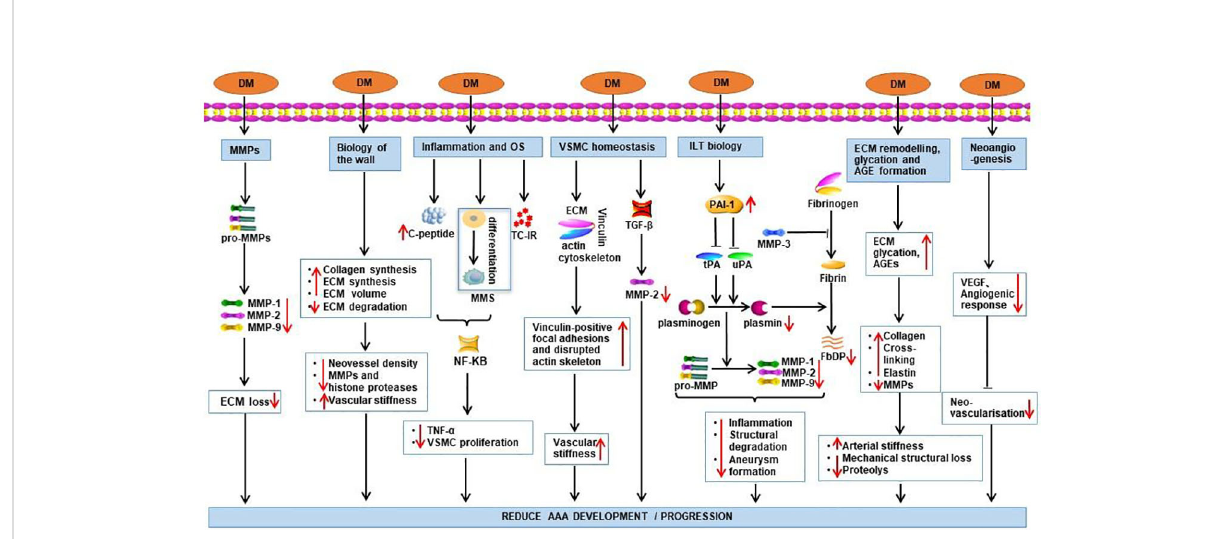
FIGURE 1 Potential mechanisms by which DM exerts its protective effect on AAA. Effects of DM are demonstrated by red arrows. TC-IR, T-cell insulin receptors; DM, diabetes mellitus; MMS, monocyte-macrophage system; OS, oxidative stress; FbDP, Fibrin degradation products; VSMC, Vascular smooth muscle cells; ILT, intraluminal thrombus; PAI-1, Plasminogen activator